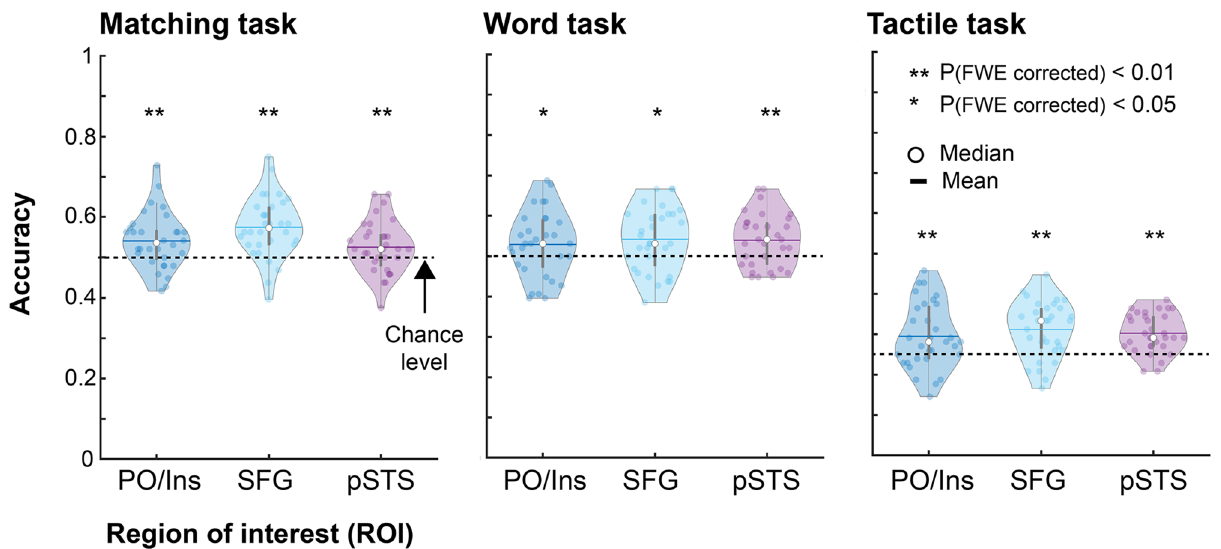
Figure 6. Multi-voxel pattern analysis on object compliance. Distributions of performance accuracy of MVPA. Each dot indicates the performance for each subject. Asterisks indicate the result of permutation tests (with Bonferroni correction). PO/Ins, parietal operculum/insula; SFG, medial superior frontal gyrus; pSTS, region in and around the superior temporal sulcus; FWE, family-wise error. Note that dot lines indicate the theoretical chance level: 50% for the matching and word judgment tasks and 25% for the tactile